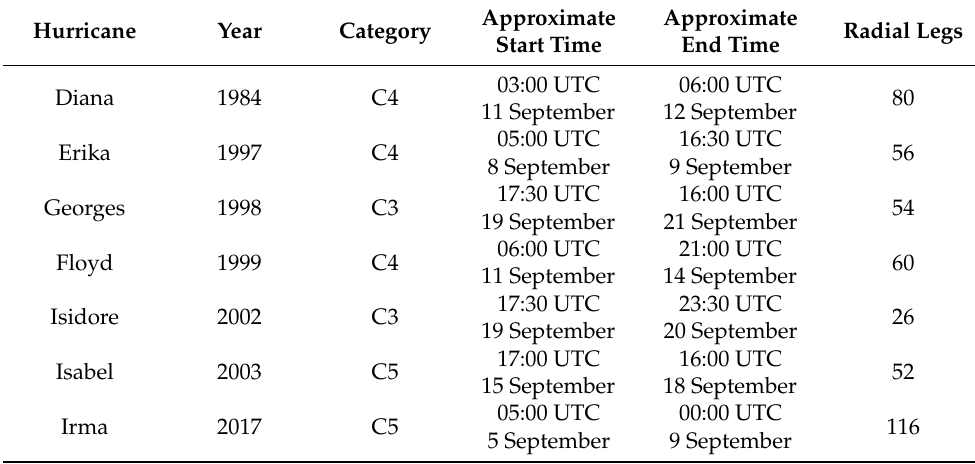
Table 1. Details of the radial legs collected from multiple aircraft